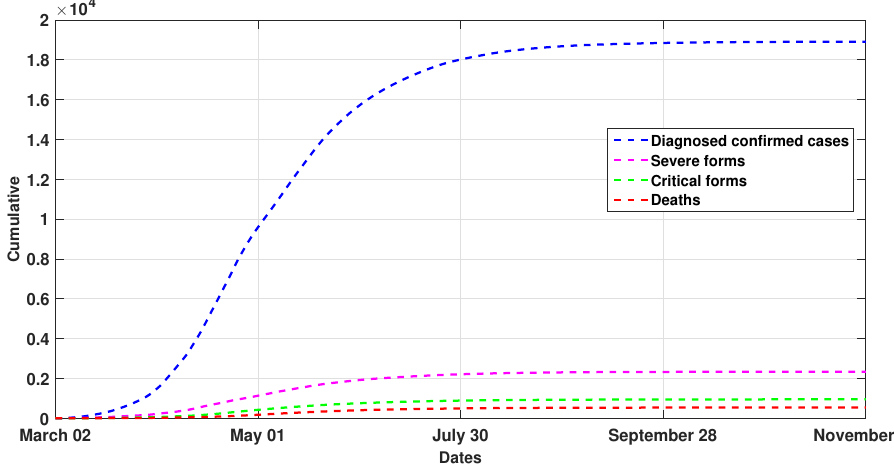
Figure 4. Cumulative diagnosed cases, severe forms, critical forms and deaths after 240 days of the start of the COVID-19 pandemic in Morocco. Table 2. Estimated peaks and cumulative of diagnosed cases, severe forms, critical forms and deaths.